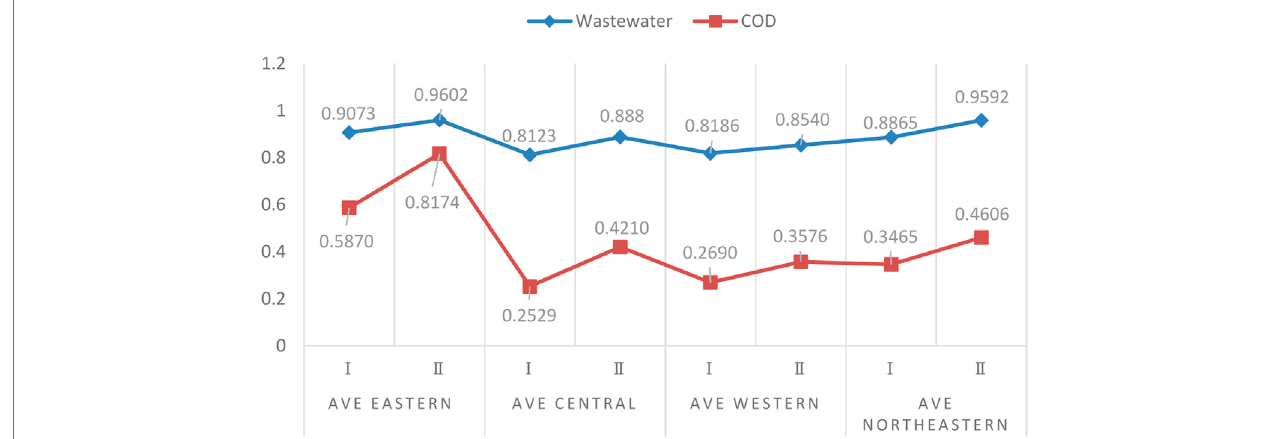
FIGURE 4 | Five-year mean value of waste and COD ef fi ciencies in each region.